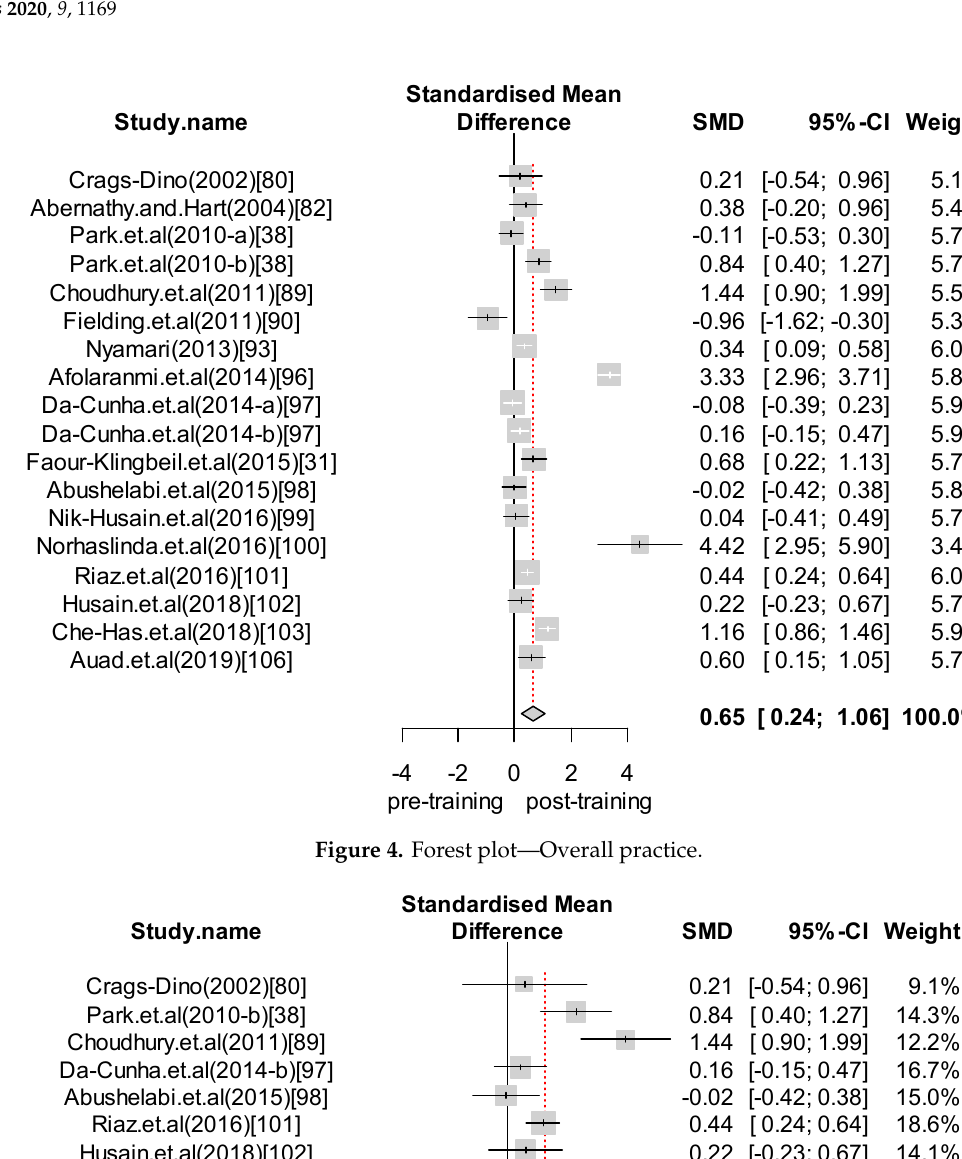
Figure 3. Forest plot—Attitude.